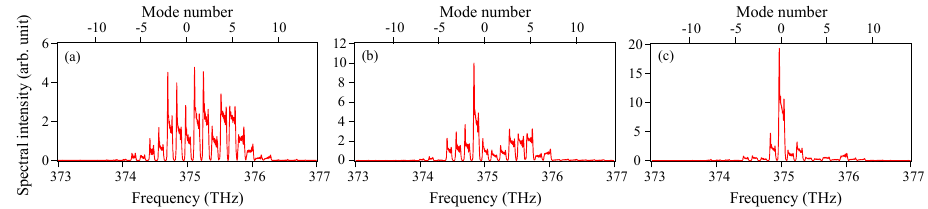
Figure 3. Examples of power spectra of the single-shot gain-switched pulses with Langevin noise included. Langevin noise amplitudes are different for the respective cases of ( a – c ).